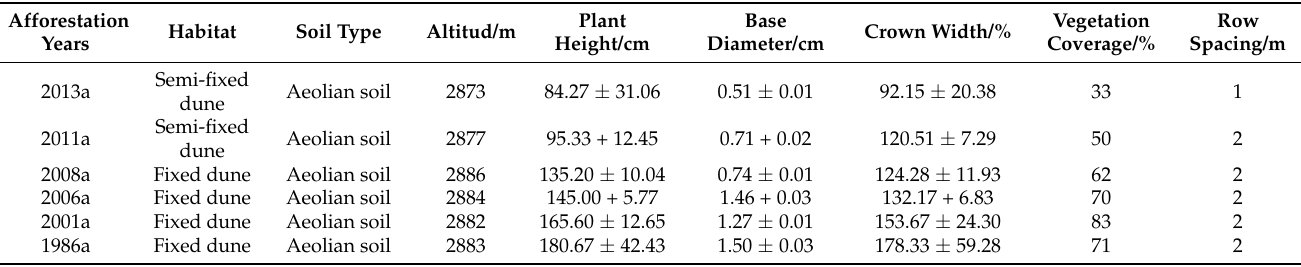
Table 1. Basic overview of the sample